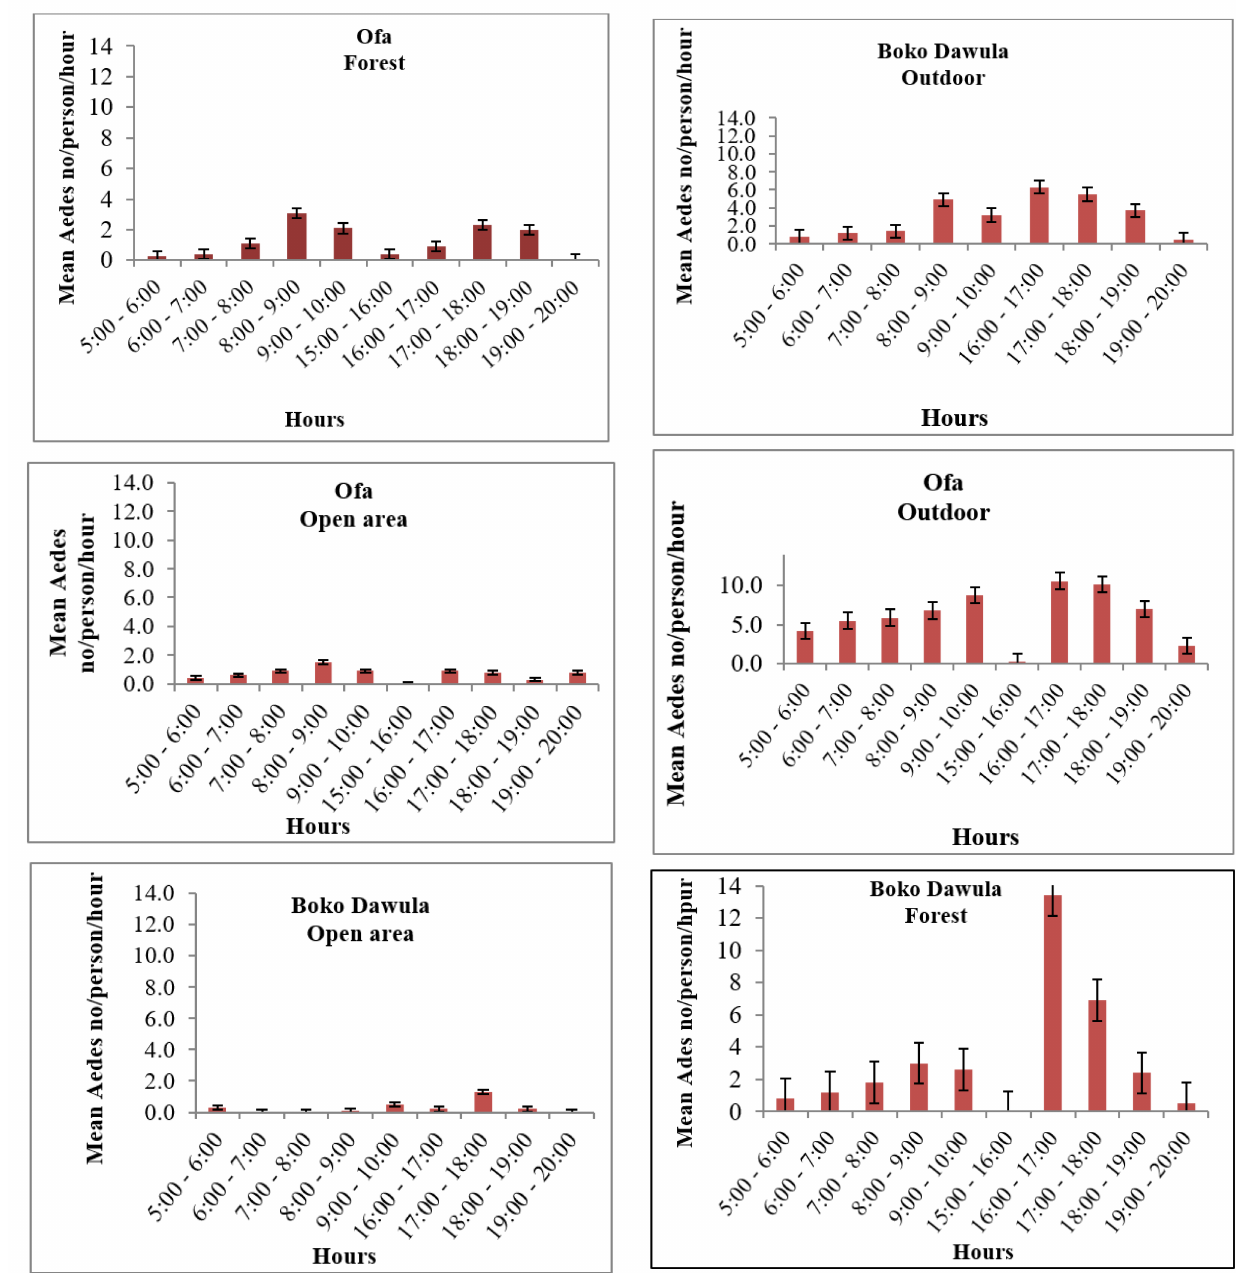
Figure 4. Hourly biting activity of Aedes simpsoni complexes/person/h in Boko Dawula and Ofa districts, southwest